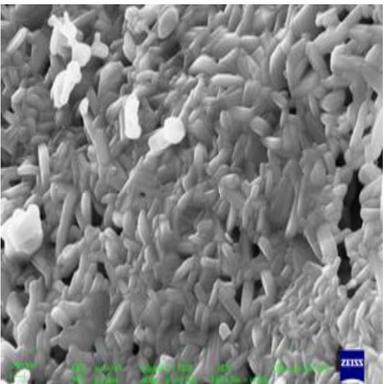
The scanning electron micrograph showing the morphology and particle distribution in BHF.